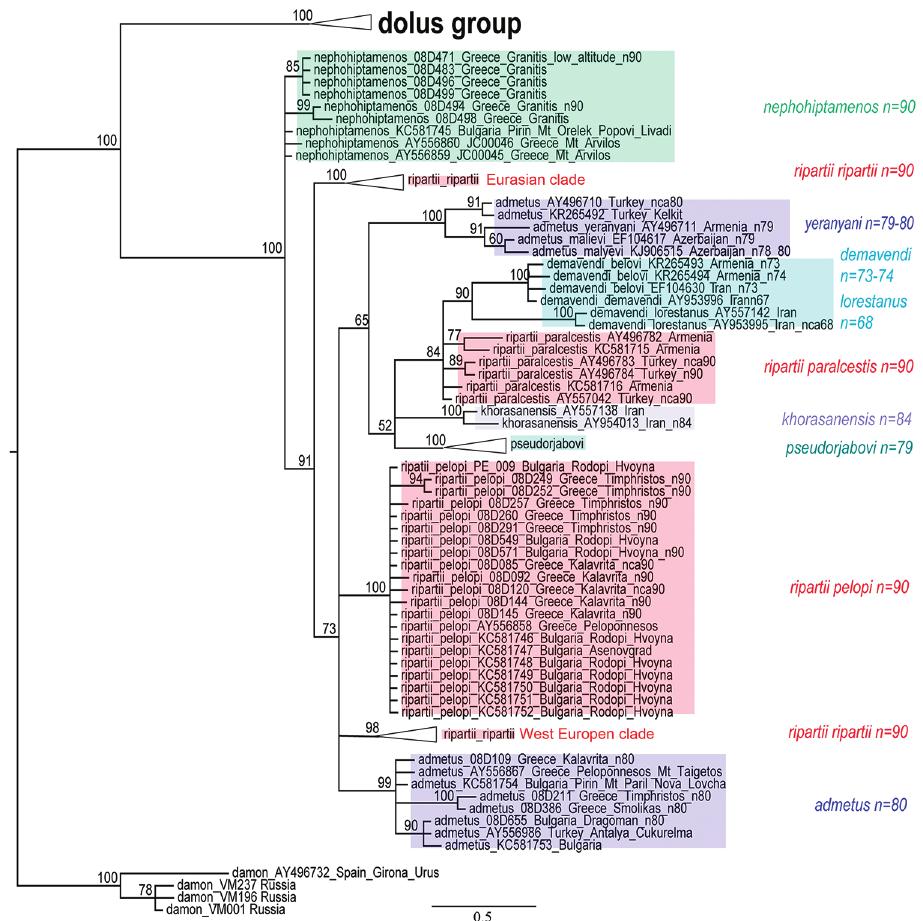
Figure 6. Fragment of the Bayesian tree of P. admetus and P. dolus complexes based on analysis of COI barcodes and focused on P. nephohiptamenos , P. admetus and P. ripartii pelopi . Polyommatus pseudorjabovi clade is not shown in details, for its composition see Lukhtanov et al. (2015a). The West-European and the “mixed” (Eurasian) clades of P. ripartii are shown in Fig. 7. Polyommatus dolus group is shown in Fig. 8. Numbers at nodes indicate Bayesian posterior